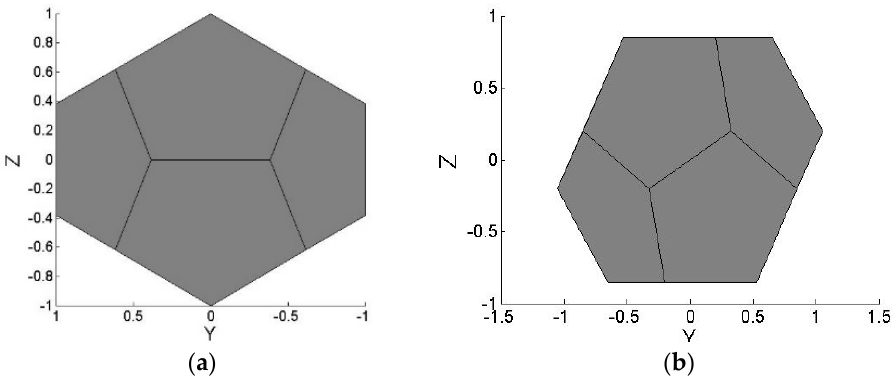
Figure 5. Regular and rotated dodecahedrons. ( a ) Regular dodecahedron; ( b ) Rotated dodecahedron.